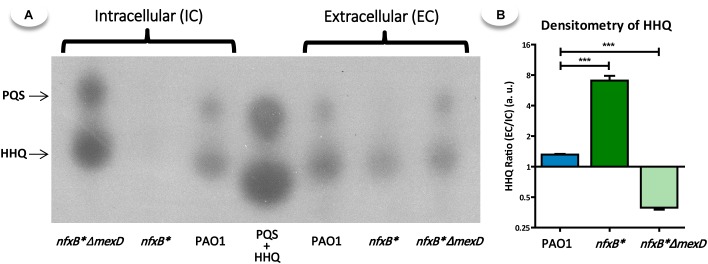
PQS and HHQ production is impaired in the strain that overproduces the MexCD-OprJ efflux pump. (A) To determine the accumulation levels of the autoinducers synthesized by Pseudomonas aeruginosa, a technique based on TLC coupled with a PqsR-based biosensor was used. The samples were extracted from cultures in early stationary phase (OD600 = 2.5). (B) The TLC-spots corresponding to HHQ were quantified by densitometry and the ratio between the HHQ present in the supernatant respect to cell extract was calculated and represented. Statistical significances were evaluated by using a Student’s two-tailed test and considered significant if P < 0.05, with a confidence interval of 95% (∗P < 0.05; ∗∗P < 0.01; ∗∗∗P < 0.001). As shown, overexpression of the MexCD-OprJ efflux system in nfxB∗ strongly reduces the production of PQS and HHQ as compared with PAO1 and nfxB∗ΔmexD strains. Furthermore, the analysis by densitometry of the HHQ ratio shows that this defect in AQs production is likely caused by an excessive extrusion of HHQ through MexCD-OprJ.